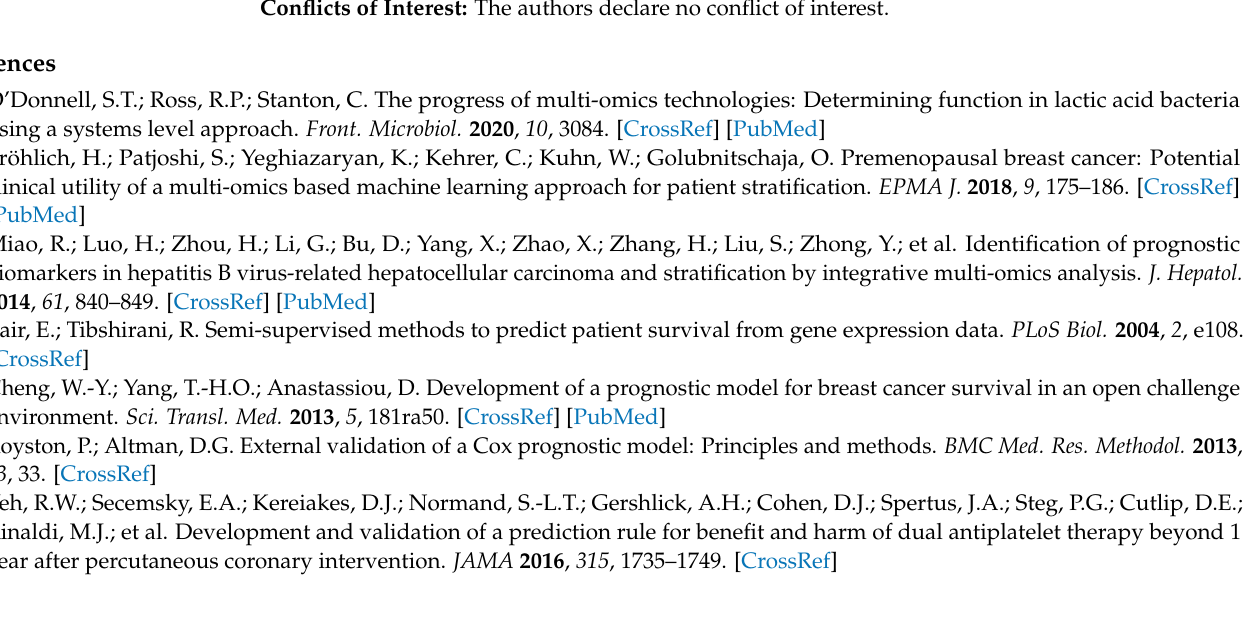
Supplementary File 2: Supplementary tables and figures. Table S1: Performance of the survival models for multiple combinations of omics datasets and different ways to represent the data. The total performance of 48 models is depicted using three metrics: C-index, Brier score, and IPCW score. Table S2: Reference table for the twelve combinations of omics data analyzed in the study. For every omics set denoted by Roman numerals, the ‘+’ sign implies the inclusion of the corresponding omics data type. Table S3: Details of hyperparameters used for training the ML model. Figure S1: Detailed methodology with CNN architecture for survival prediction model. Figure S2: Model architecture for mRNA as an input. Figure S3: Model architecture for miRNA as an input. Figure S4: Model architecture for methylation as an input. Figure S5: Model architecture for mRNA and methylation as inputs. Figure S6: Model architecture for mRNA and miRNA as inputs. Figure S7: Model architecture for mRNA, miRNA, methylation as inputs. Figure S8: A stacked plot representing the number of patients that actually had an event that was predicted by the model. For the testing set, about 85% people in the low-risk set were found to be living while, about 61% of high-risk patients died during the given time period. Figure S9: Enriched terms from KEGG 2019 Human pathways, GO Biological processes and Cell type (Human gene atlas) for (A–C) under-expressed gene-set. Figure S3: Model architecture for mRNA as an input. Figure S10: (A) Generate lower dimensional representations of data. (B) Find a minimum bounding rectangle and re-orient. (C) Label each point in the image according to the value in omics data. For pixels with multiple genes, take an average and replace the value. Figure S11: Silhouette analysis on the clustered cancer genes for both the approaches (t-SNE and UMAP) helped us to optimize the parameters used for the generation of images. For t-SNE, perplexity was optimized, while number of neighbors and minimum distance were optimized for